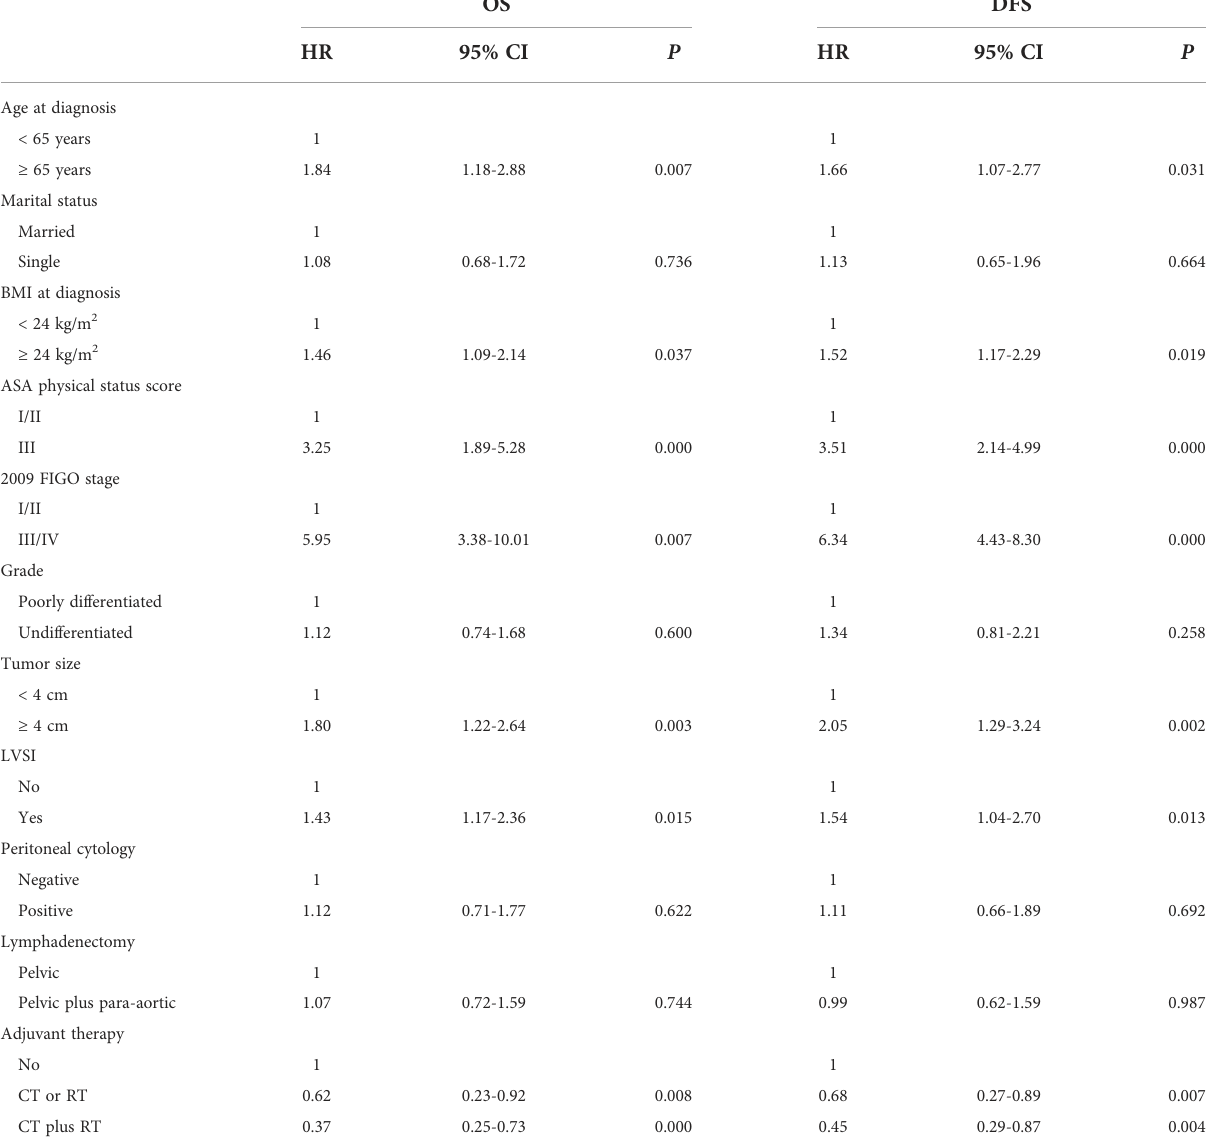
TABLE 3 Univariate analyses of survival for apparent early-stage uterine clear cell